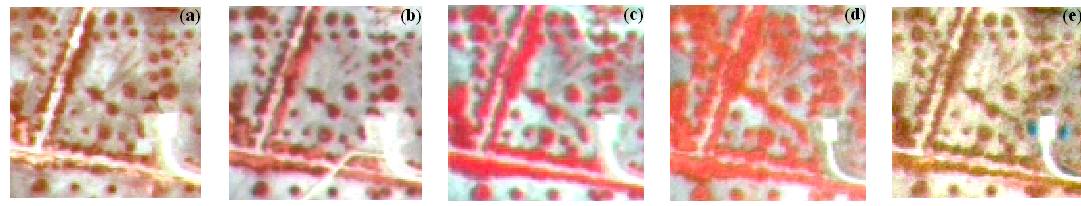
Figure 13. Part of the CBERS-04 fusion false color images (RGB432). ( a ) 27 March 2017; ( b ) 18 May